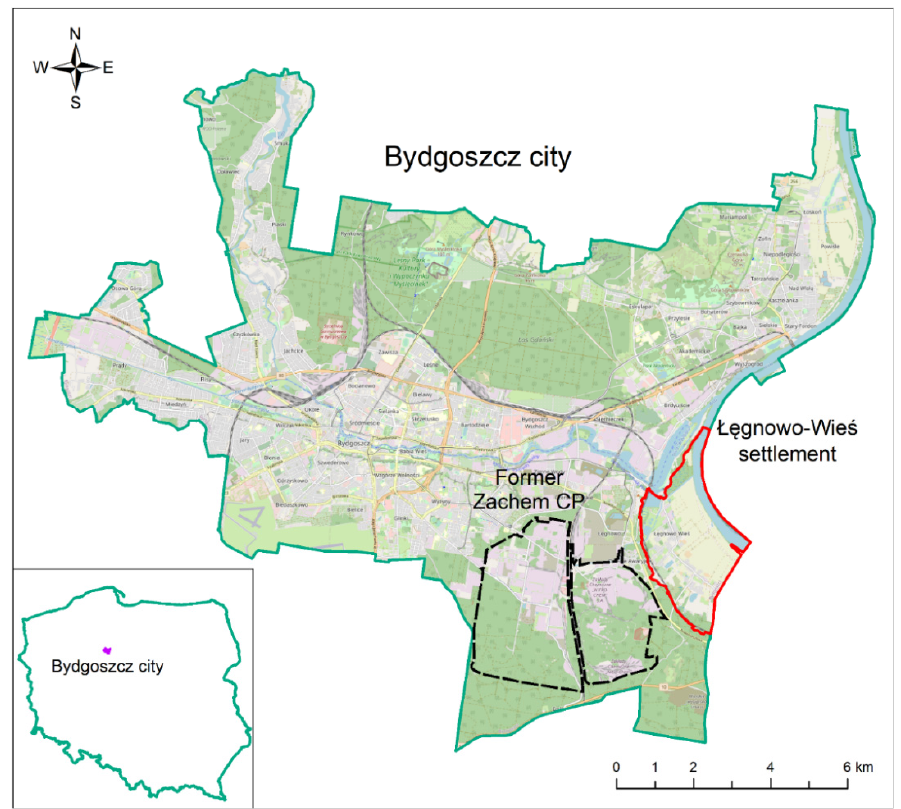
Figure 1. Location of the former Zachem Chemical Plant and the Łę gnowo-Wie ś settlement on the map of Bydgoszcz, Poland.